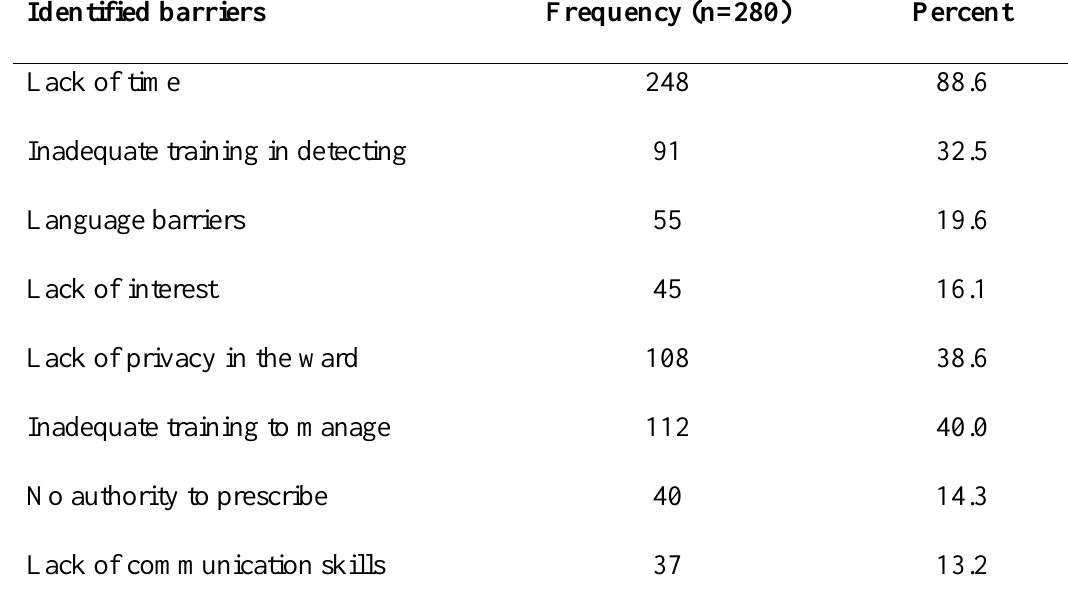
Table 3-Distribution of the study population who identified barriers to screen and manage alcohol misuse among patients in the ward setup by their responses Identified